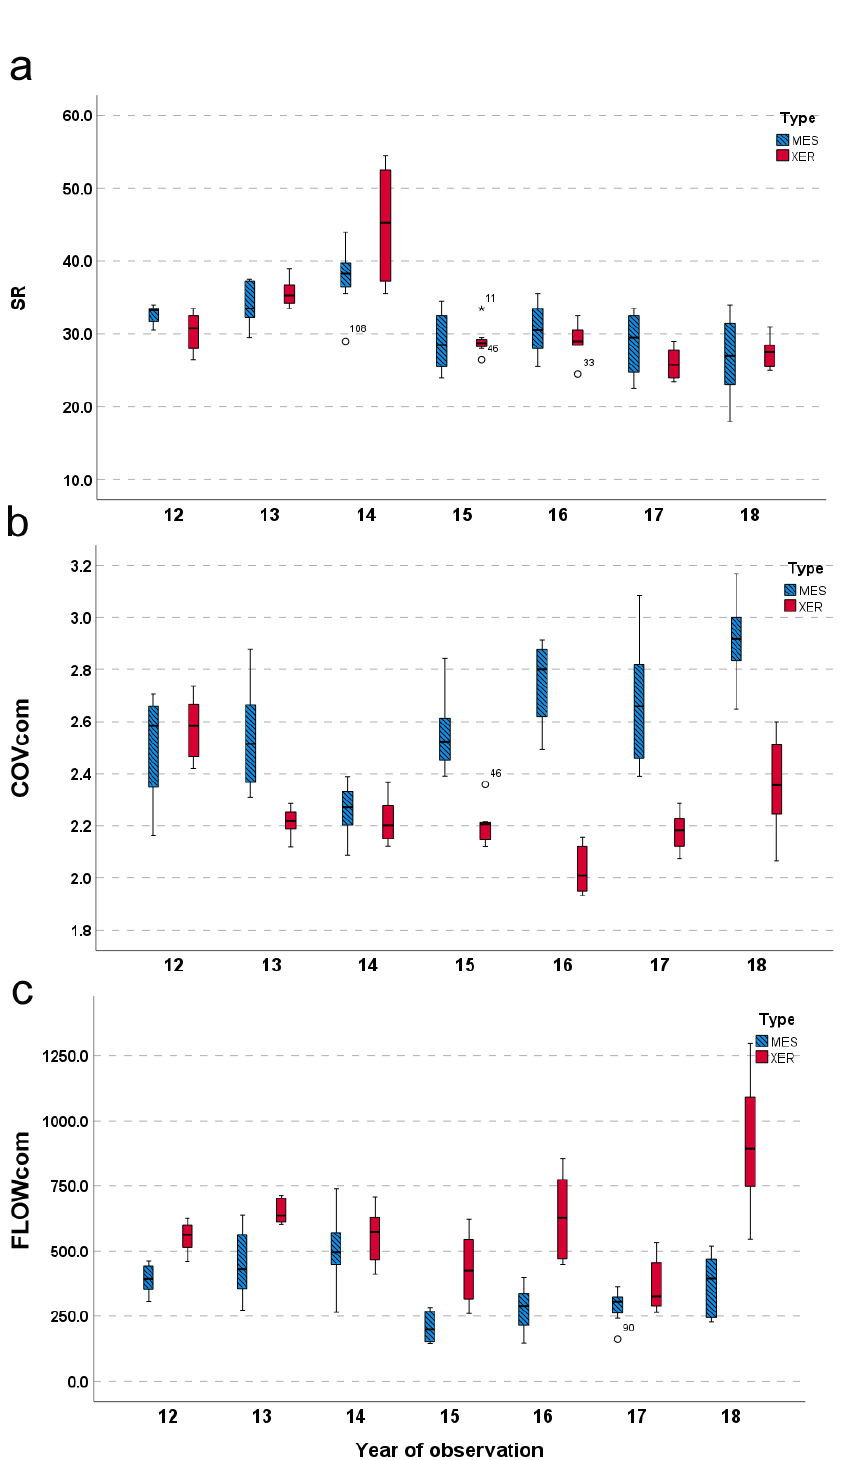
Figure 4. Variation patterns of community productivity proxies over the 7-year study period in the mesophile (MES) and xerophile (XER) communities. Abbreviations: SR = no. of species found in each plot (Species richness) ( a ); COVcom = the sum of all species cover estimated for each plot (plant cover) ( b ); FLOWcom = sum of all flowered individuals/ramet counted in each plot (Flowering rate) ( c ).